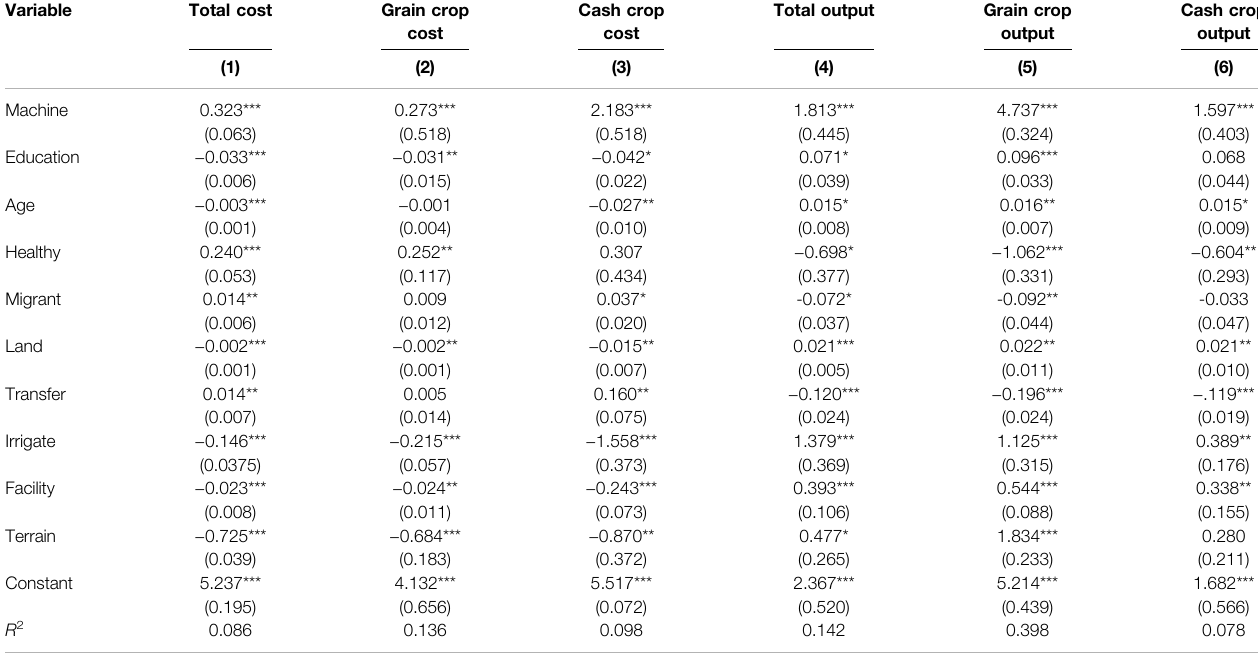
TABLE 2 | OLS estimation of the impact of agricultural mechanization level on agricultural cost and output value.